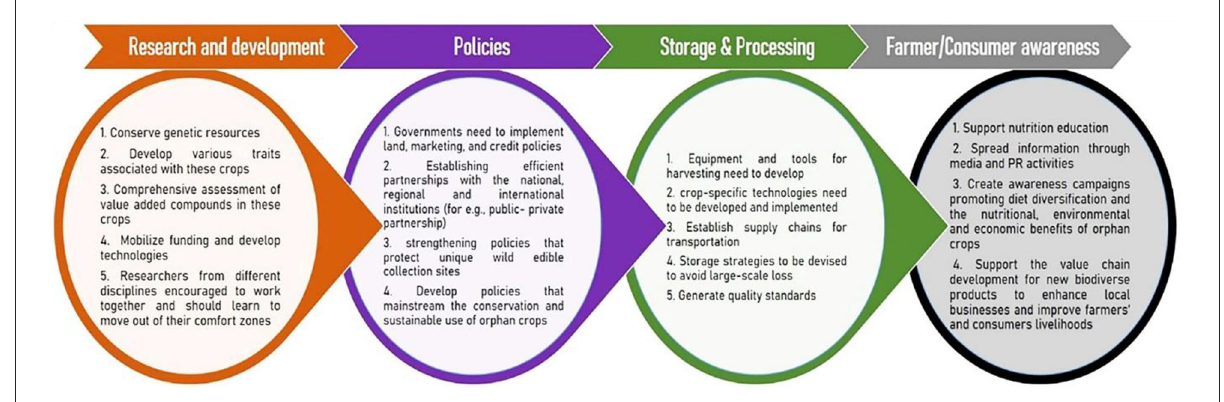
FIGURE4 Multi-stakeholders’ strategies and coordinated approaches at the local, regional, and international levels for the promotion of orphan crops for sustainable agriculture development.